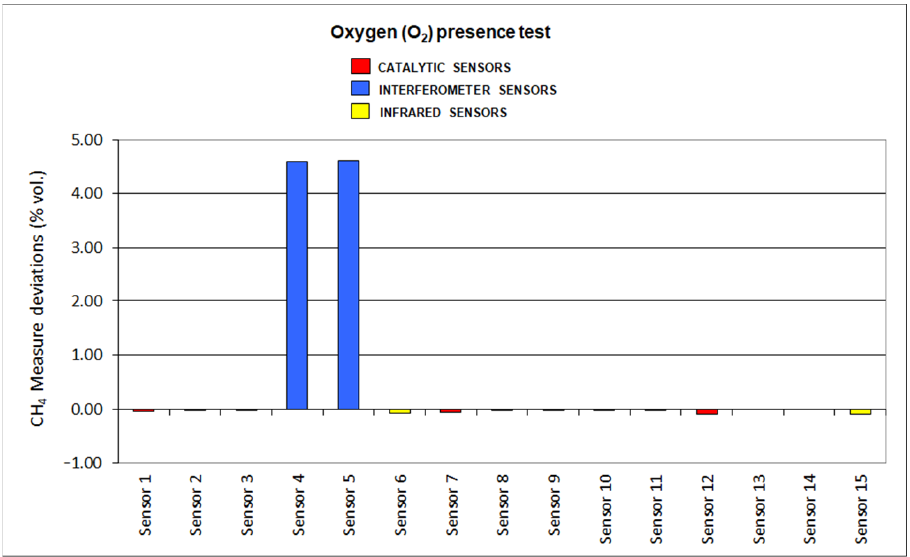
Figure 15. Oxygen presence results.